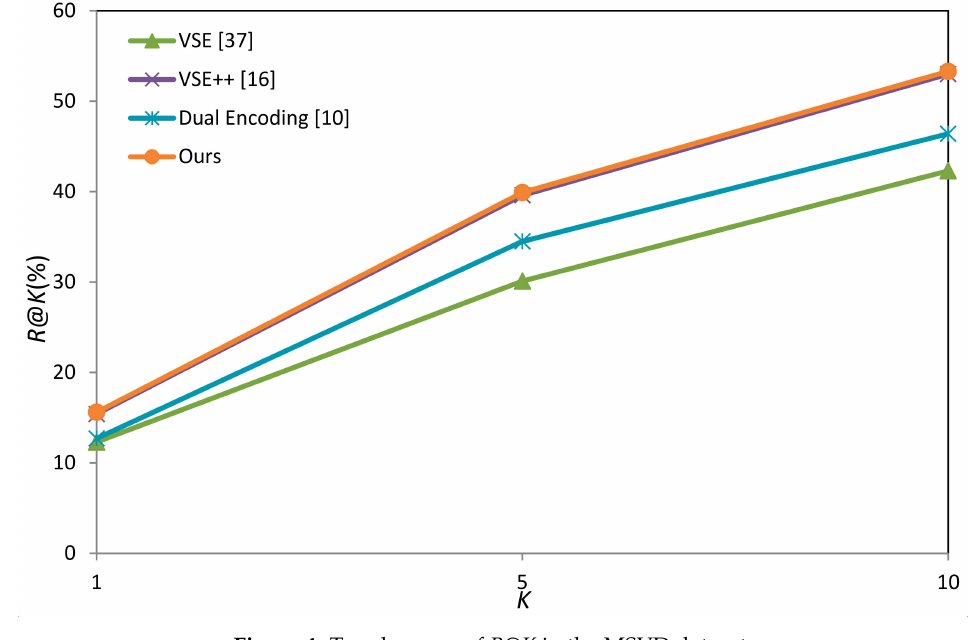
Figure 4. Trend curves of R @ K in the MSVD dataset.